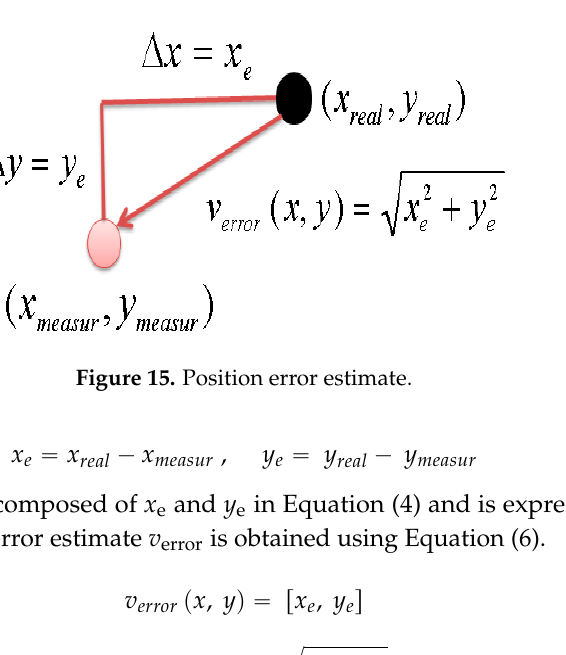
Figure 16. Position error estimate before error compensation.